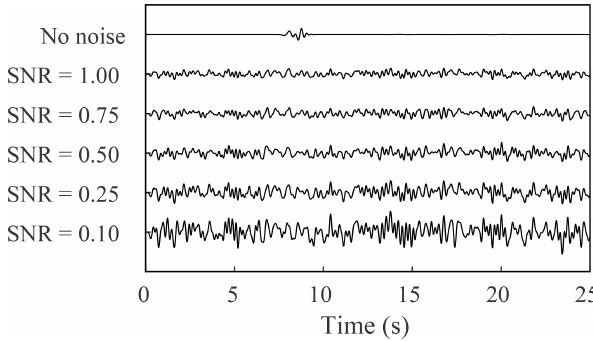
Figure 12. Example traces recorded with a receiver directly above the source for an explosion source placed at a depth of 11.9km. The traces without noise and with different degrees of noise are shown, resulting in different signal-to-noise ratios